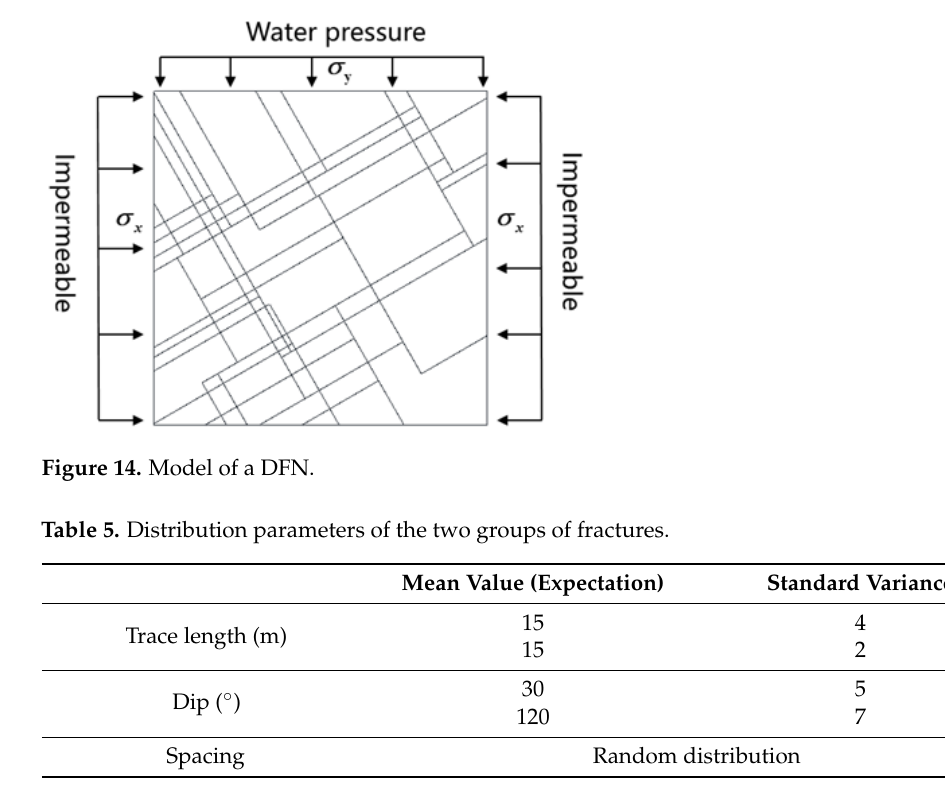
Table 6. Material parameters of the matrix and fractures.